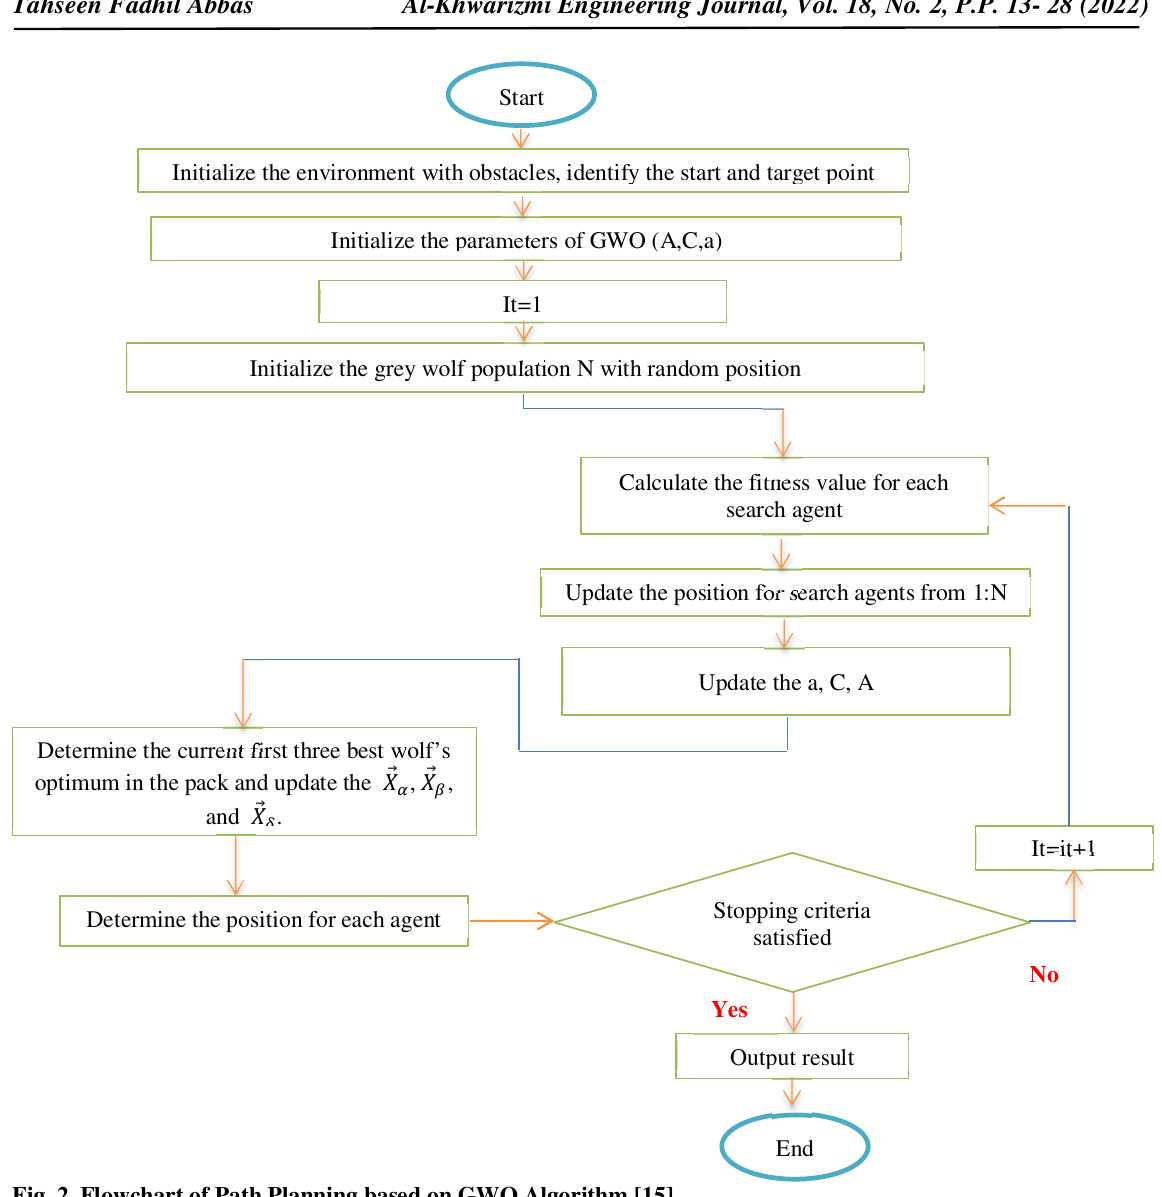
Fig. 2. Flowchart of Path Planning based on GWO Algorithm